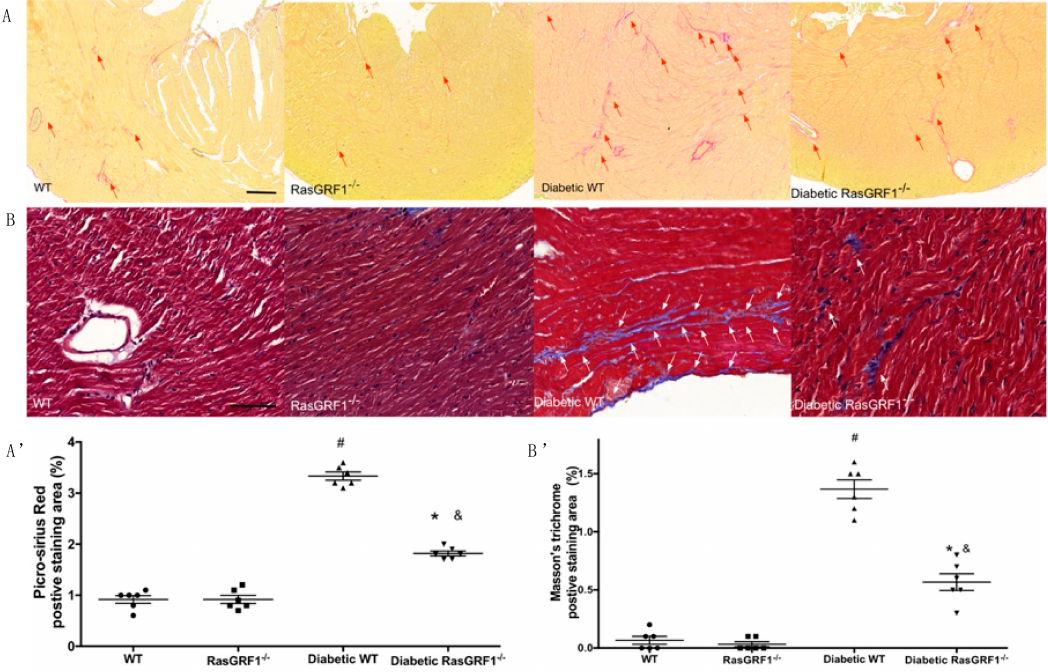
Figure 3. Effect of RasGRF1 knockout on cardiac fibrosis in diabetic mice. The deposition of collagen in cardiac tissue by picrosirius red staining ( A ) and Masson’s trichrome staining ( B ). ( A , A’ ) The picrosirius red staining was in different groups (each group n = 3). The red arrow indicated interstitial fibrosis and the red arrow indicated the perivascular fibrosis. # p < 0.01 vs. normal WT and normal RasGRF1 − / − mice; * p < 0.05 vs. diabetic WT mice. & p < 0.05 vs. normal WT and normal RasGRF1 − / − mice. ( B , B’ ) The Masson’s trichrome staining in different groups (each group n = 3). The white arrow indicated fibrotic area. # p < 0.01 vs. normal WT and normal RasGRF1 − / − mice; * p < 0.05 vs. diabetic WT mice. & p < 0.05 vs. normal WT and normal RasGRF1 − / − mice. WT: wild type; Scale bar = 200 μ m. 2.5. Deficiency of RasGRF1 Prevented Inflammatory Cytokine and Extra-Matrix Deposition Production in the Hearts of Diabetic Mice Monocytes have major roles in initiating and promoting inflammatory processes, which are a major cause of cardiac fibrosis. We observed higher positive CD11b and vimentin cells in diabetic mice (group 3 and group 4) than in the non-diabetes group (group 1 and 2) (Figure 4). These findings were reversed in the diabetes-RasGRF1 − / − group. The monocyte chemoattractant protein-1 (MCP-1) is one of the chemokines that regulates the migration of monocytes, whereas fibronectin is a well-known extracellular matrix protein. The diabetes WT mice showed significant upregulation of MCP-1 and fibronectin-positive cells compared to the control group and the RasGRF1 − / − group (Figure 5). In addition, the diabetic RasGRF1 − / − mice attenuated the expression of MCP-1 and reduced the fibronectin deposition.